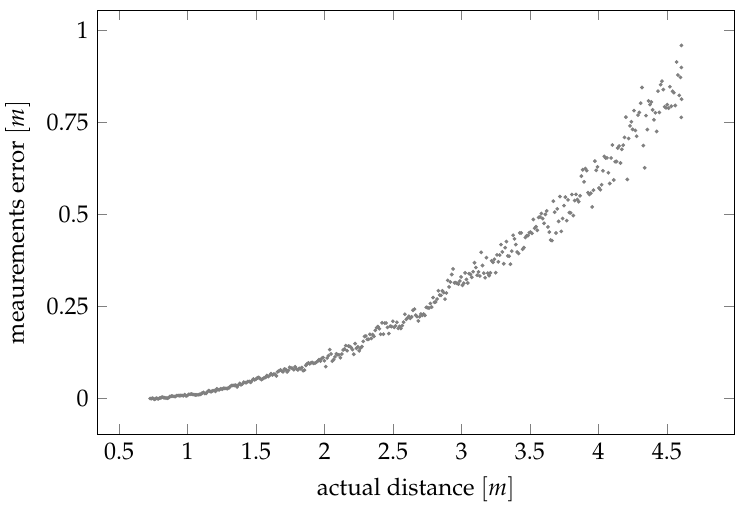
Figure 1. An example of a series of raw measurements obtained using a non-calibrated distance sensor (in this case the triangulation lidar described in Section 4.3).